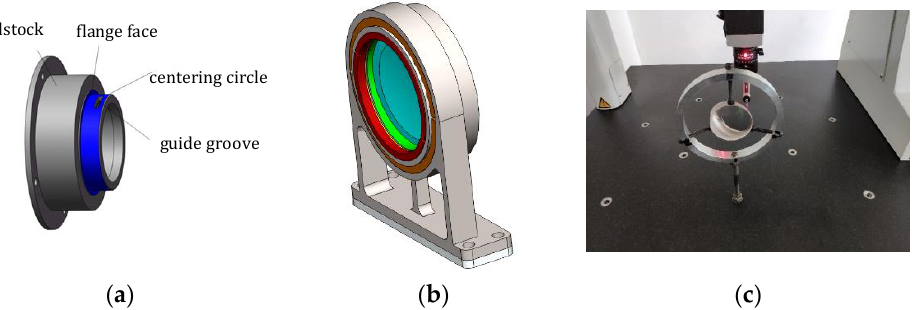
Figure 5. Mechanical design of the catadioptric prism and prism testing process: ( a ) Centering tailstock of the prism frame; ( b ) components of the assembled structure; ( c ) prism testing.